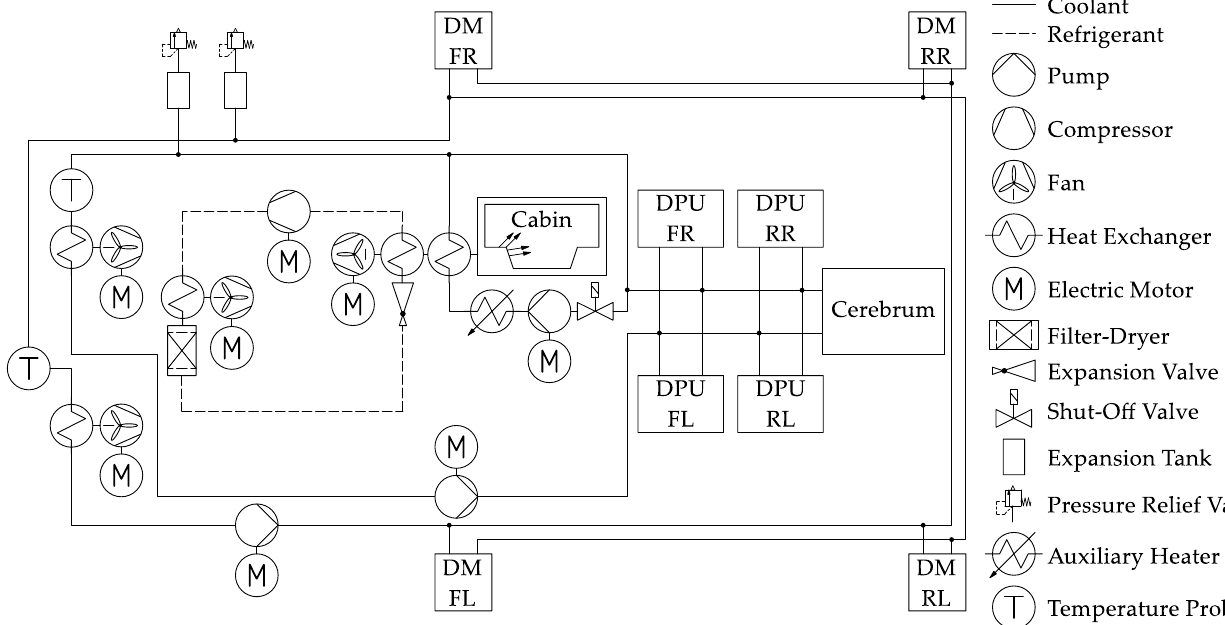
Figure 1. Implemented thermal management system topology in UNICARagil.